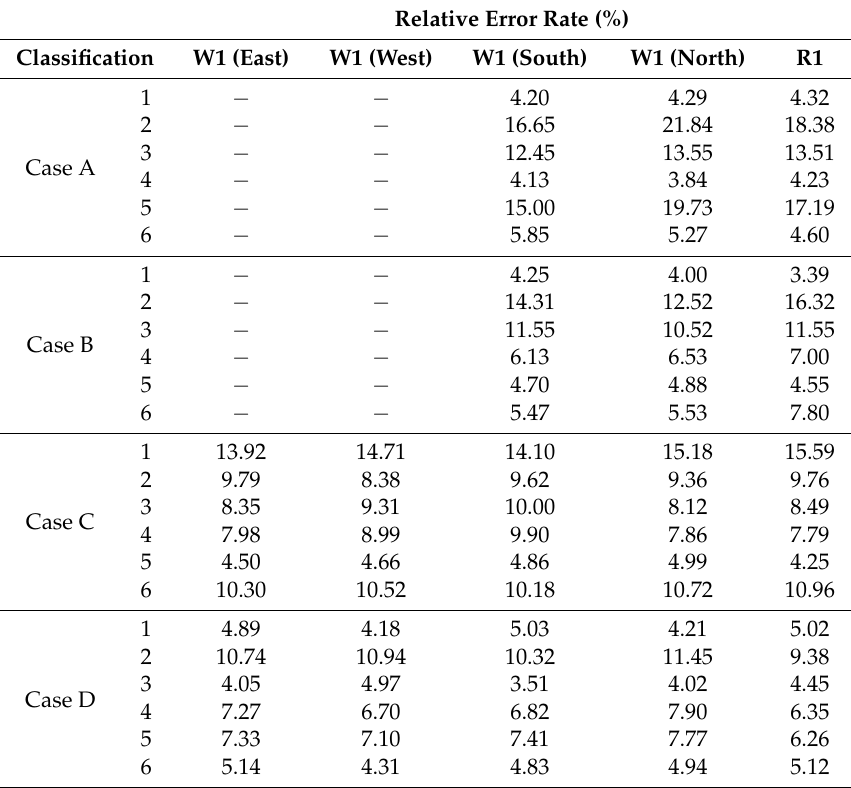
Table 9. Relative error rate in the presence or absence of sampled